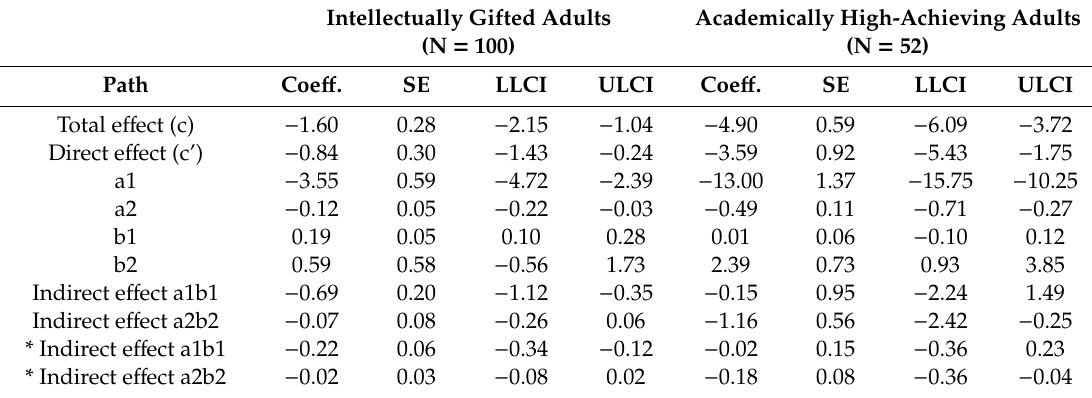
Table 2. Path coe ffi cients of the multiple mediation analyses, standard errors, and 95% percentile confidence intervals predicting subjective well-being among Intellectually Gifted Adults (N = 100) and Academically High-Achieving Adults (N = 52). Intellectually Gifted Adults Academically High-Achieving Adults (N = 100) (N = 52) Path Coe ff . SE LLCI ULCI Coe ff . SE LLCI ULCI Total e ff ect (c) − 1.60 0.28 − 2.15 − 1.04 − 4.90 0.59 − 6.09 − 3.72 Direct e ff ect (c’) − 0.84 0.30 − 1.43 − 0.24 − 3.55 − 15.75 − 10.25 a2 − 0.12 0.05 − 0.22 − 0.03 − 0.49 0.11 − 0.71 − 0.27 b1 0.19 0.05 0.10 0.28 Indirect e ff ect a1b1 − 0.69 0.20 − 1.12 − 0.35 − 0.15 0.95 − 2.24 1.49 Indirect e ff ect a2b2 − 0.07 0.08 − 0.26 0.06 − 1.16 0.56 − 0.25 * Indirect e ff ect a1b1 − 0.22 0.06 − 0.34 * Indirect e ff ect a2b2 − 0.02 0.03 − 0.08 0.02 − 0.18 0.08 − 0.36 −